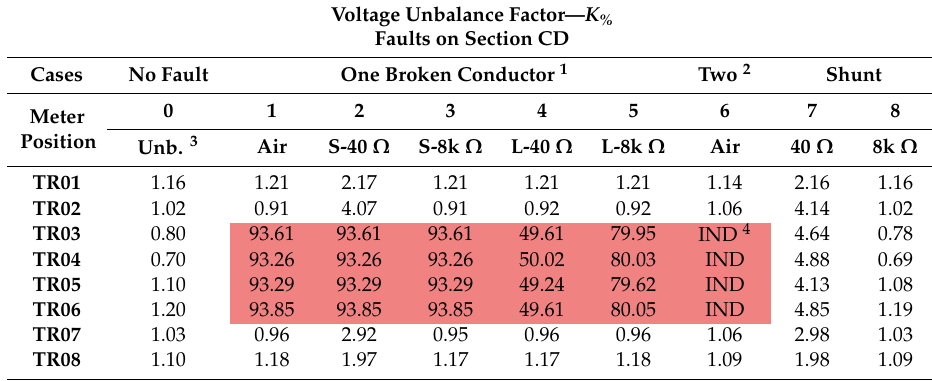
Table 7. Faults on section CD—voltage unbalance (results of K % for normal and fault condition). Voltage Unbalance Factor— K % Faults on Section